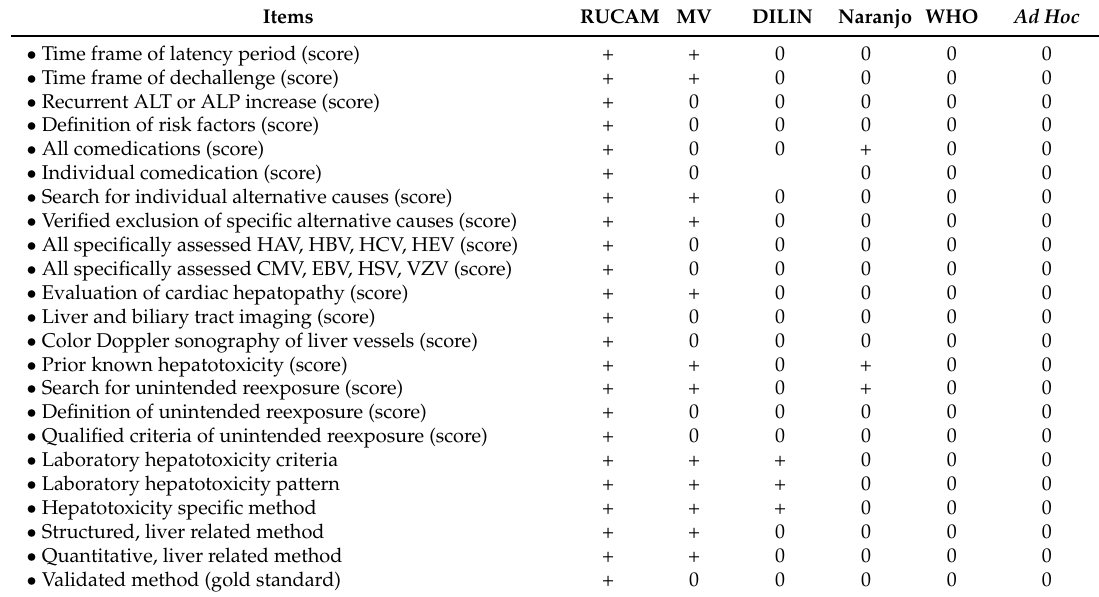
Table 6. Core elements of the updated RUCAM as compared to other causality assessment methods. Data for RUCAM are derived from the updated RUCAM (Tables 2 and 3 and Figure 1), for MV from the report of Maria and Victorino [41], For DILIN from the Drug Induced Liver Injury Network method [33,54,55], for Naranjo from the report of Naranjo et al. [56], for the WHO from the WHO database [57], and for the ad-hoc approach from Kaplowitz [58]. The symbol + shows that this specific item is published, and the symbol 0 indicates lacking publication. Abbreviations: ALT: